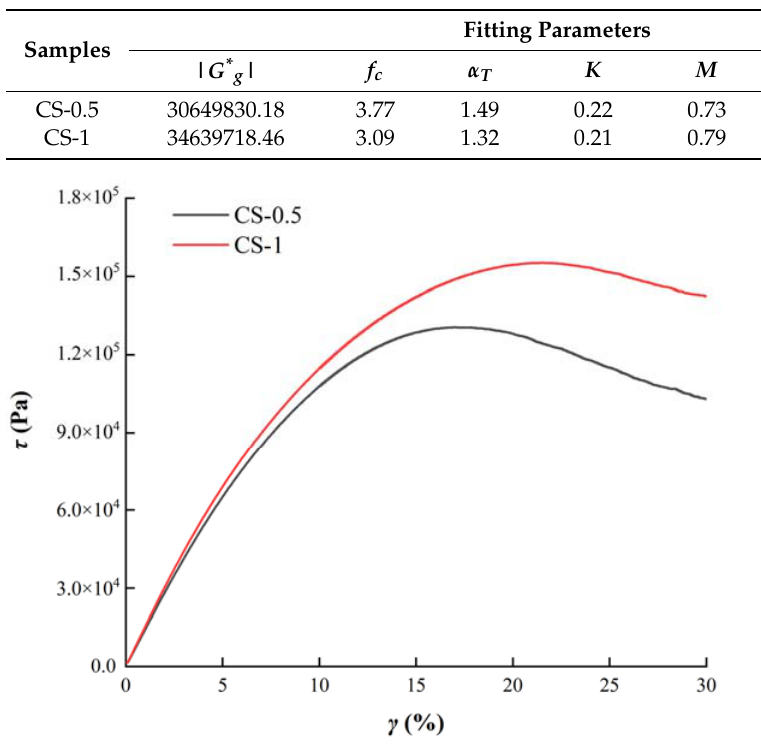
Table 8. Master curves fitting parameters.